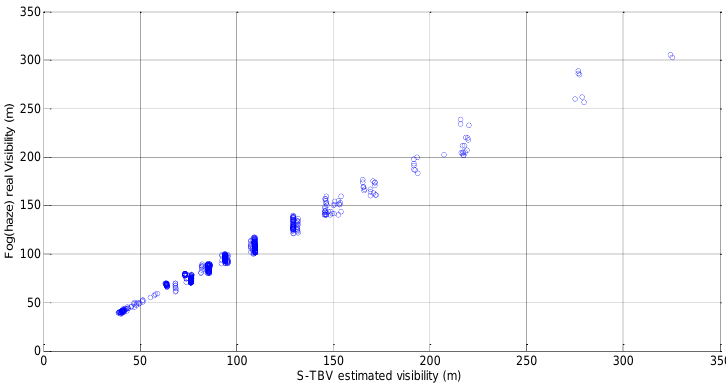
Figure 10. The scatter plot between the visibility estimated by the TBV approach and the real visibility.